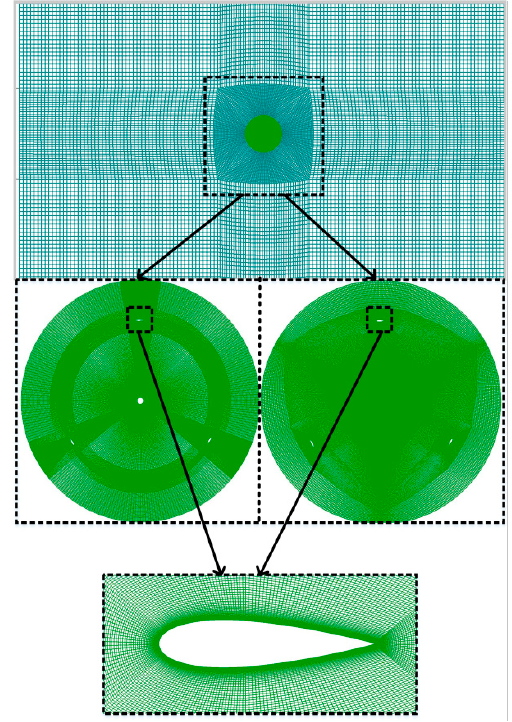
Figure 2. Meshing details: entire mesh in computational domain, mesh in the inner region and mesh near the airfoil.